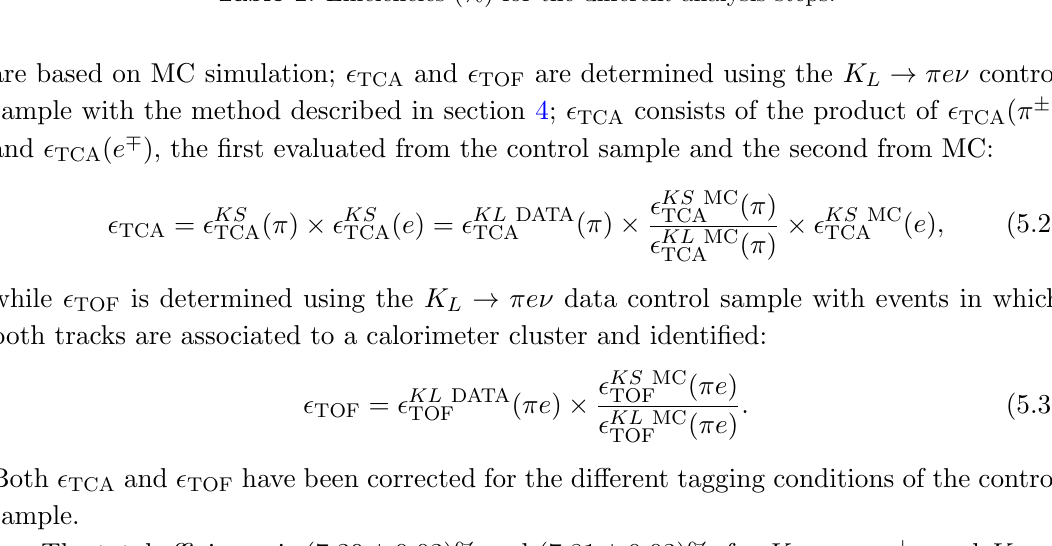
Table 1 . E(cid:14)ciencies (%) for the di(cid:11)erent analysis